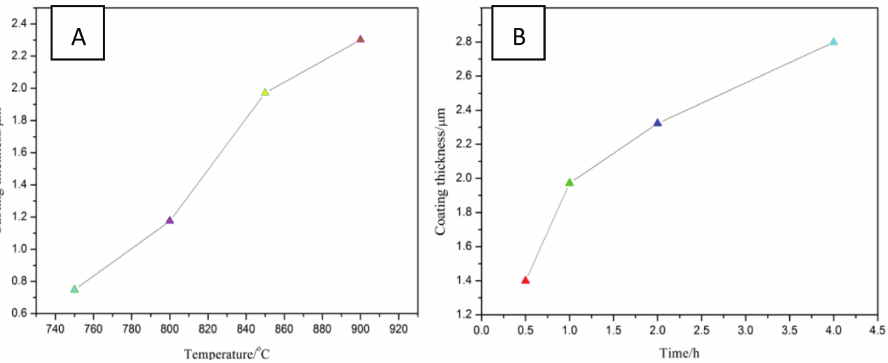
Figure 10: The relationship between coating thickness and (a) plating temperature and (b) holding